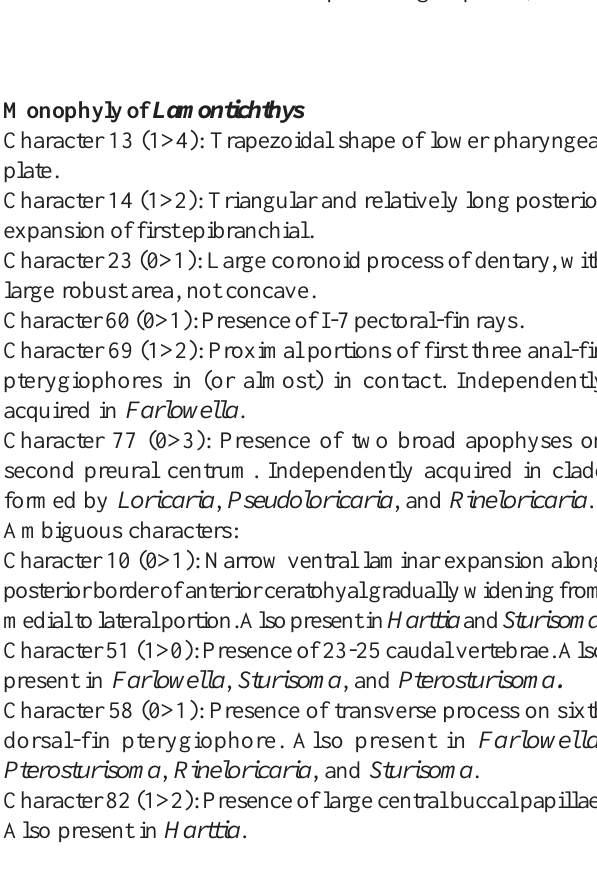
Fig. 54. Dorsal view of the predorsal plates of (a) Sturisoma sp. (MZUSP 50112, 115.2 mm SL) and (b) Lamontichthys avacanoeiro (MNRJ 18553, 98.1 mm SL, paratype). Odontods not represented. Scale bar = 2 mm. Fig. 55. Strict consensus of the three most parsimonius hypotheses of relationships of species of Lamontichthys and allied genera (L = 194; CI = 0.73; RI = 0.78, see text for considerations about relationships of outgroup